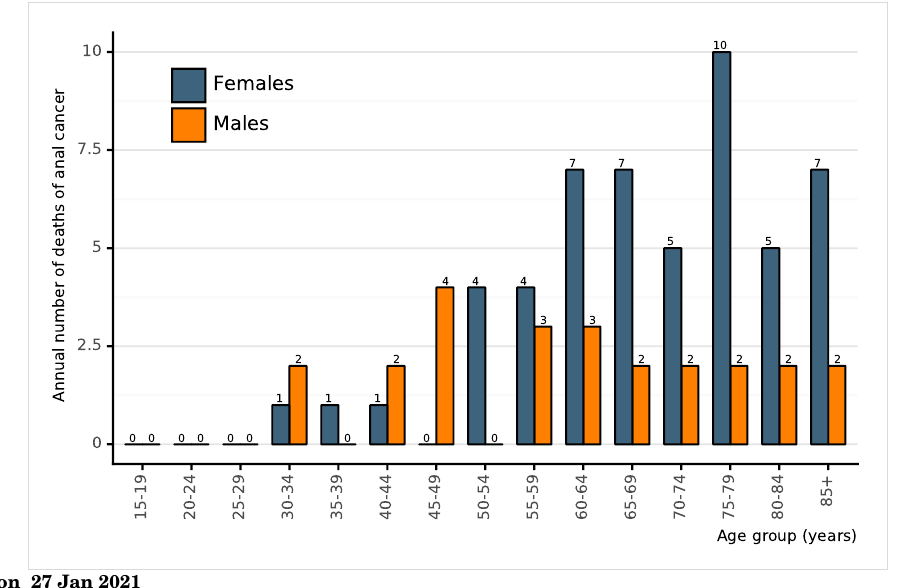
Figure 18: Annual number of deaths of of anal cancer in Peru (estimates for